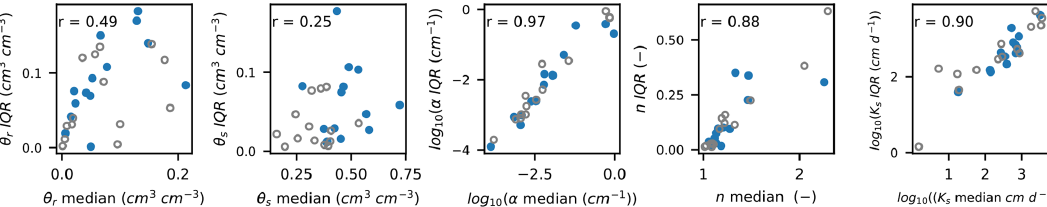
Figure 5. Correlations between median parameter estimates and the 95% interquantile range (IQR) from posterior parameter distributions for estimated SHPs for 14 sites – each with two soil layers (blue dots show the upper soil layer and gray circles show the lower soil layer). The α and K s parameters are shown on a log scale to better depict the range of values. Spearman’s ρ ( r ) is given for the presented correlations. The correlations were highly significant with p < 0 . 01 for α , n , and K s on a log scale as well as on a linear scale. On the linear scale, r was slightly lower for α ( r = 0 . 77) and K s ( r = 0 .